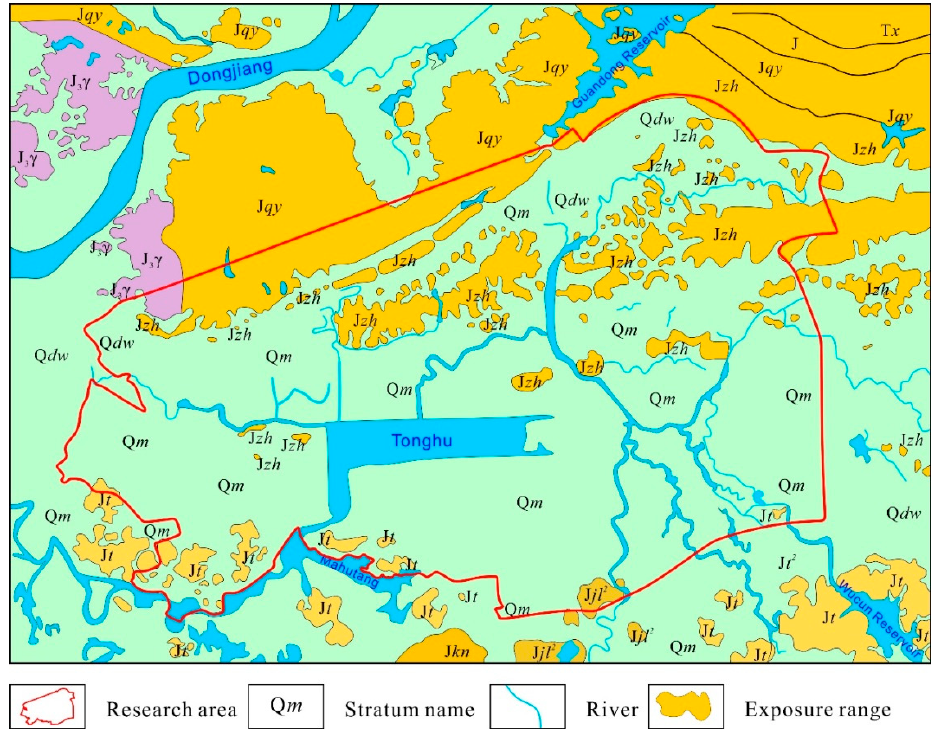
Figure 2. Distribution map of stratum exposure in research area .